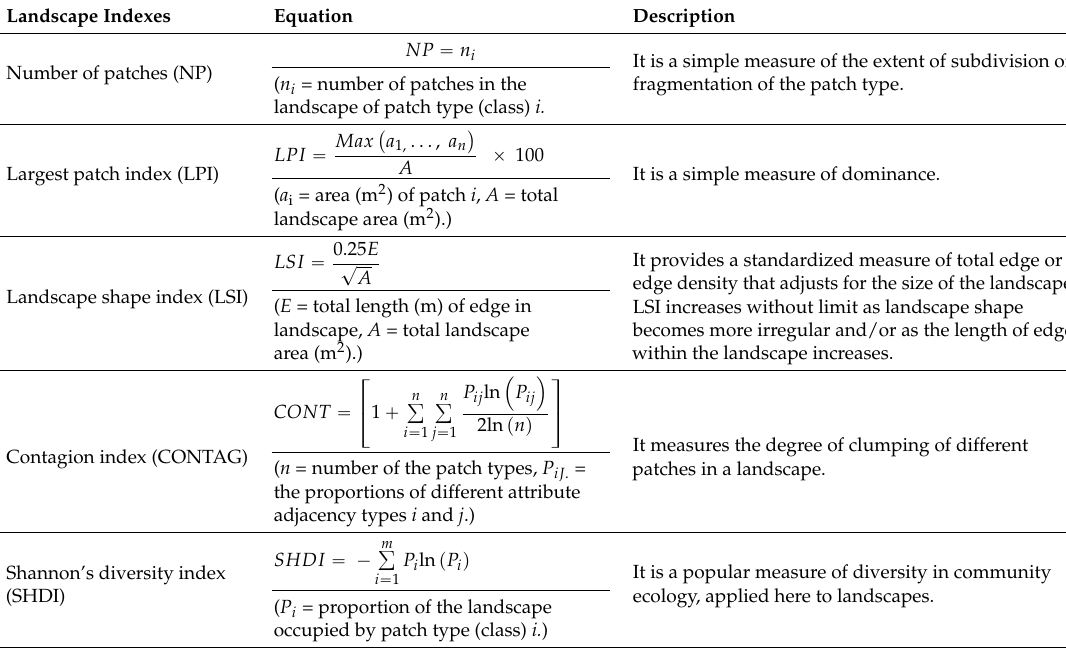
Table 2. List of landscape indexes